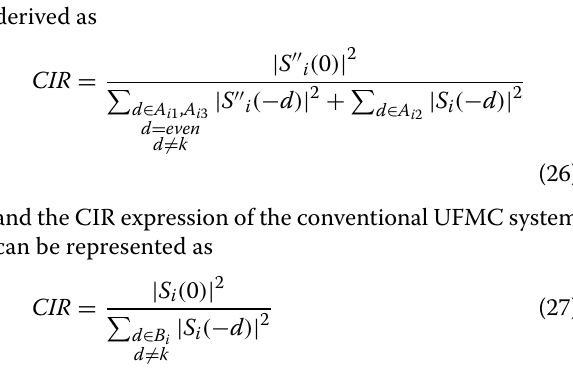
Fig. 4 CIR comparison for different systems. This figure shows the CIR comparison for different systems, including the proposed UFMC, the conventional UFMC and the standard